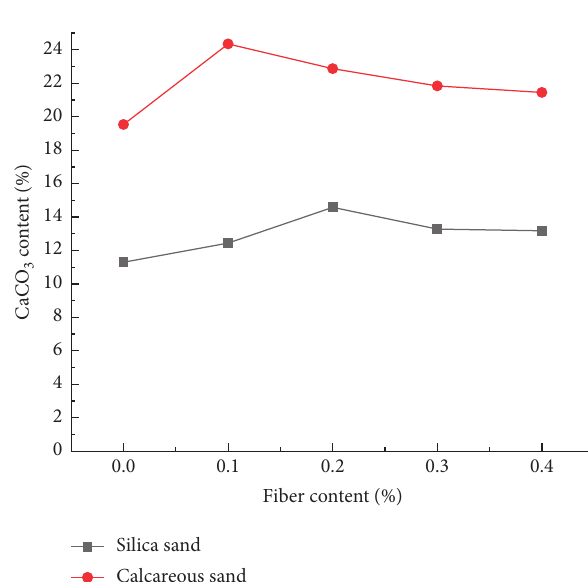
Figure 8: The average content of CaCO different fiber contents.